Question: Identify the chart type used in this figure.
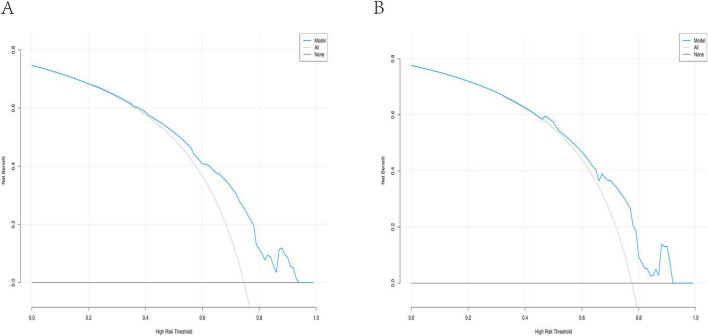
Answer: line